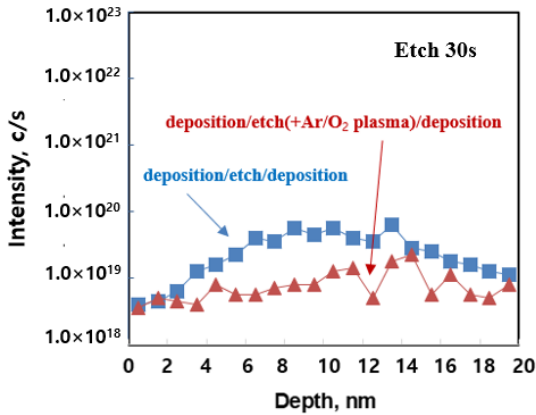
Figure 9. Fluorine concentration of thin film applied by the DED process (SIMS analysis).